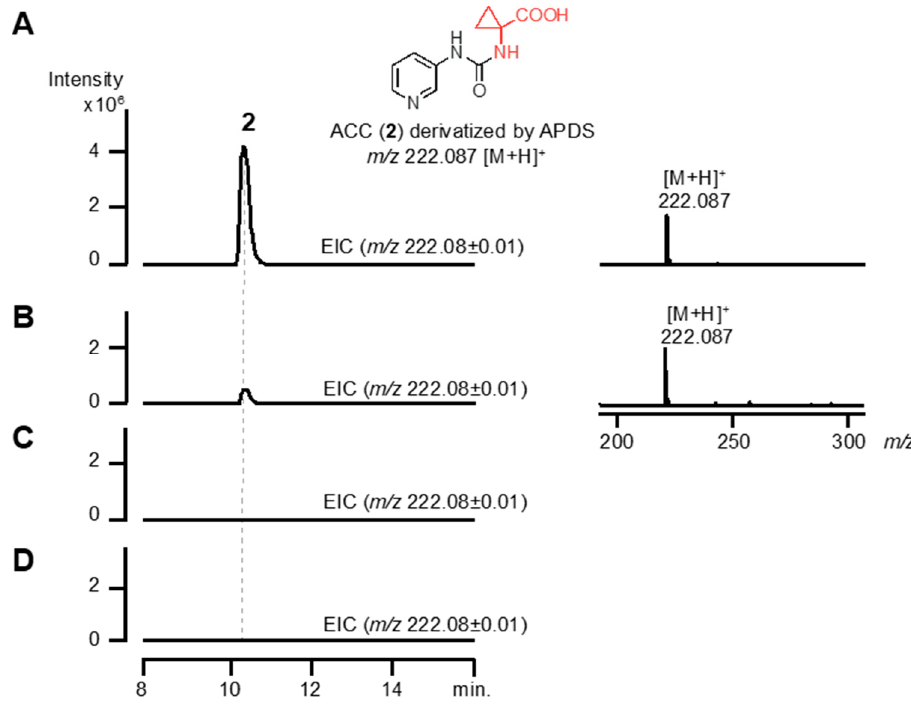
Figure 5. Enzyme reaction of rOrf30 in vitro. Compound 2 derivatized by 3-aminopyridinyl- N -hydroxysuccinimidyl carbamate (APDS) was used as a standard and analyzed by HPLC-HR-ESI-MS ( A ) Compound 1 or ( B ) L-methione ( C ) was incubated with rOrf30, and then the reaction product was derivatized by APDS and analyzed by HPLC-HR-ESI-MS. ( D ) Compound 1 was incubated in a reaction mixture without rOrf30, and then the reaction mixture was derivatized by APDS and analyzed by HPLC-HR-ESI-MS.